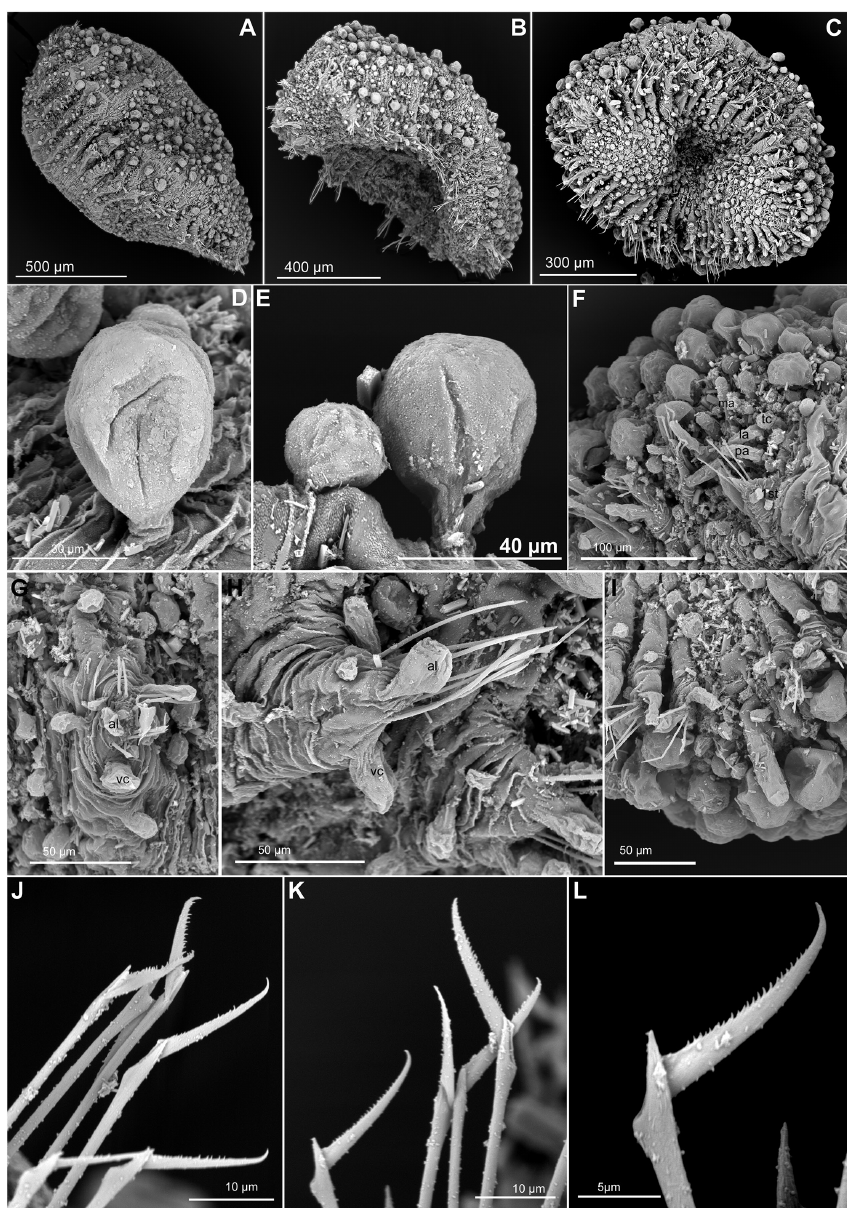
Figure 7. Sphaerodoridium minutum , paratypes USNM 22873, SEM. A Whole specimen, side view B Whole specimen, ventro-lateral view C Same, ventral view D Detail of stalked, dorsal macrotubercle E Dorsal macrotubercle and papilla F Anterior end, frontal view, showing head appendages and tuber- cles of anterior chaetigers G Mid-body parapodium, side view H Mid-body parapodia, anterior view I Posterior end and pygidium, ventral view J Chaetae anterior chaetigers K Chaetae mid-body parapodium L Detail of Mid-body chaeta. Abbreviations: al, acicular lobe; la, lateral antenna; ma, median antenna; mc, macrotubercle; mi, microtubercle; pa, palp; tc, tentacular cirrus; vc, ventral